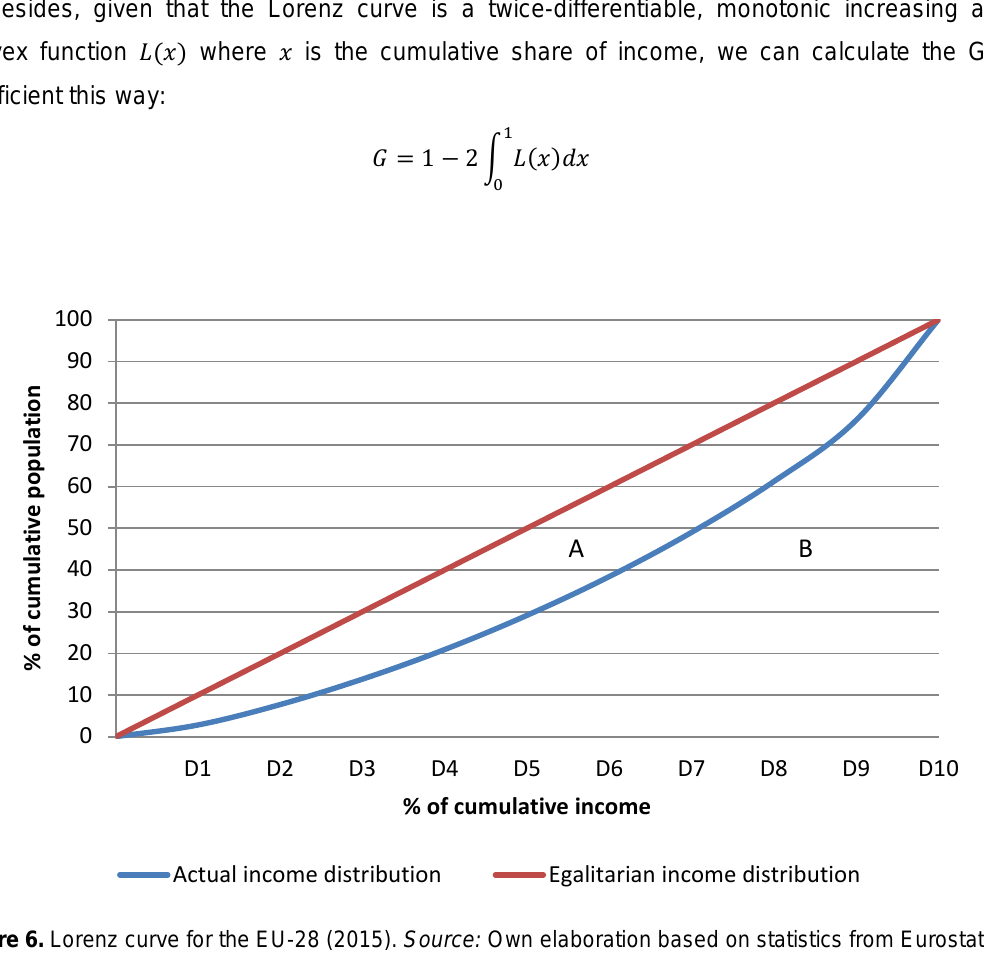
Figure 6. Lorenz curve for the EU-28 (2015). Source: Own elaboration based on statistics from